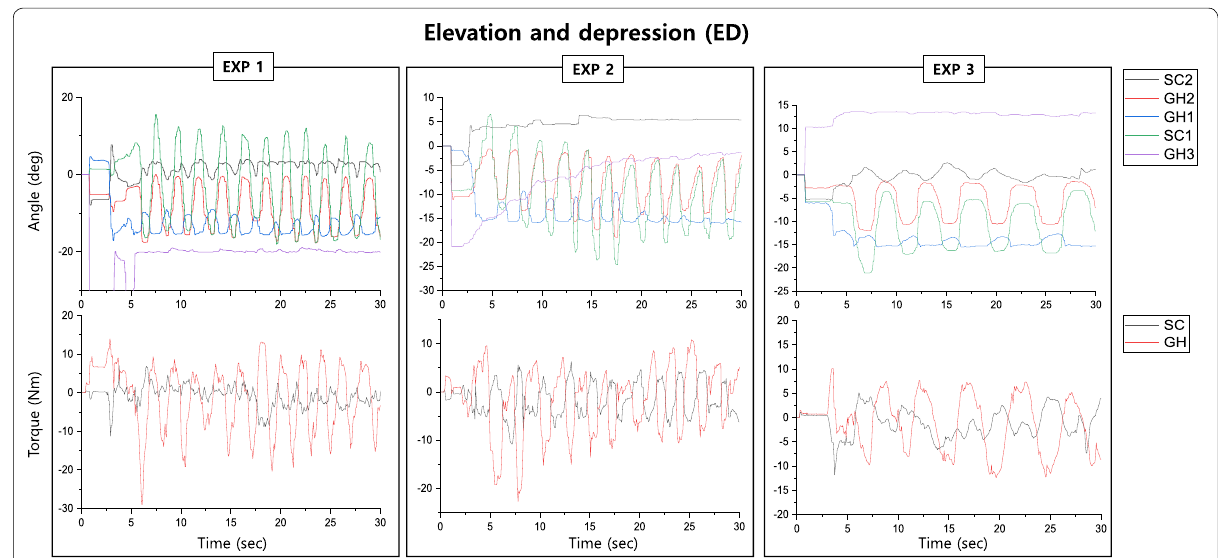
Fig. 5 Experiment values of the raw data of angle and torque in elevation and depression (ED) exercise from the experts ( EXP expert, SC sterno‑clavicular joint, GH glenohumeral joint). The x‑axis indicates the time (unit: second). The top and bottom y‑axes represent the angle (unit: degree) and torque (unit: Nm), respectively